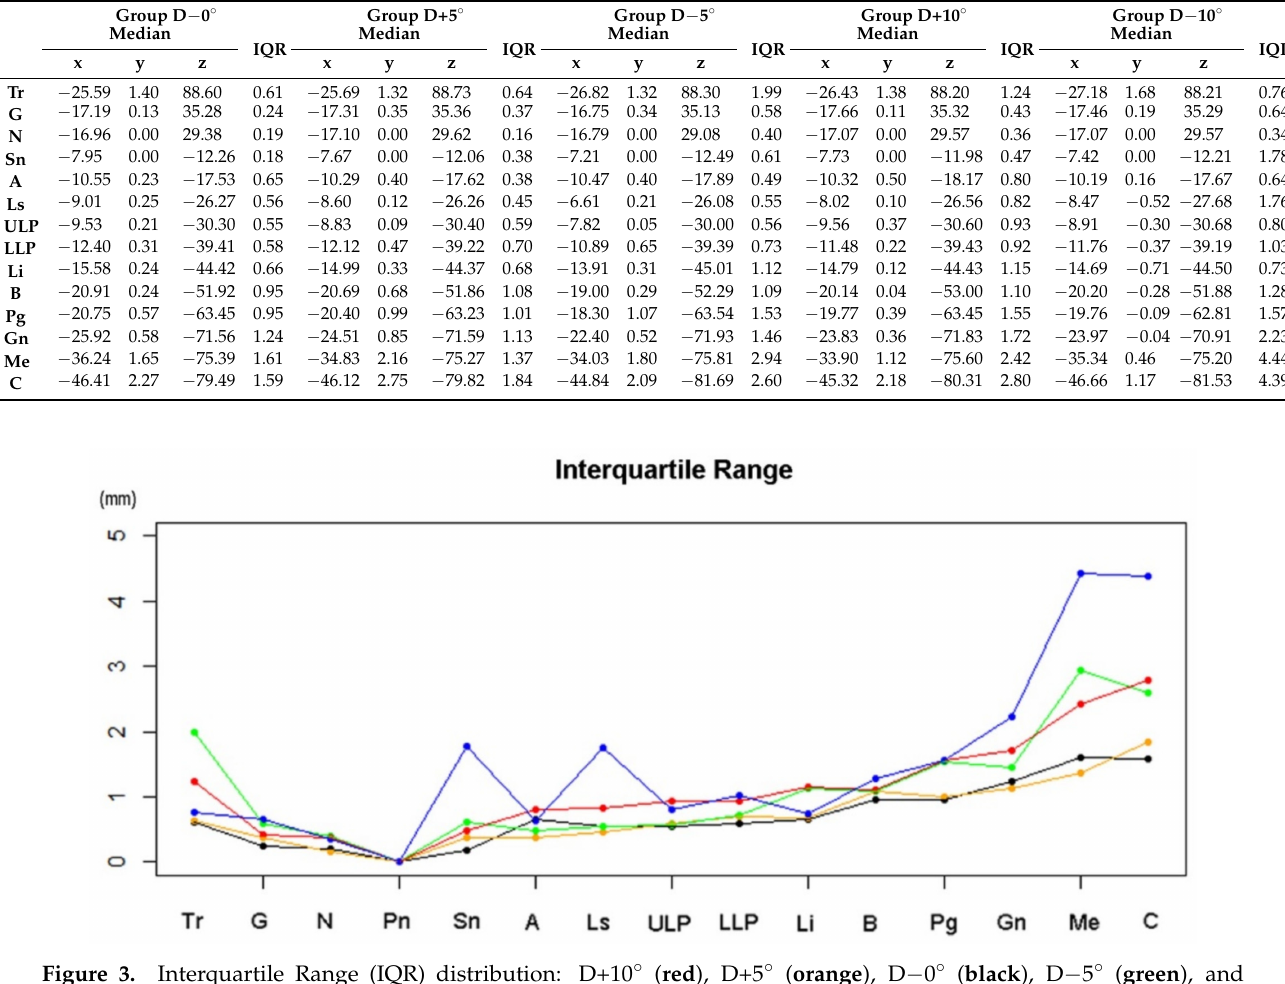
Table 1. Median coordinates and interquartile range (IQR) of each group (mm).